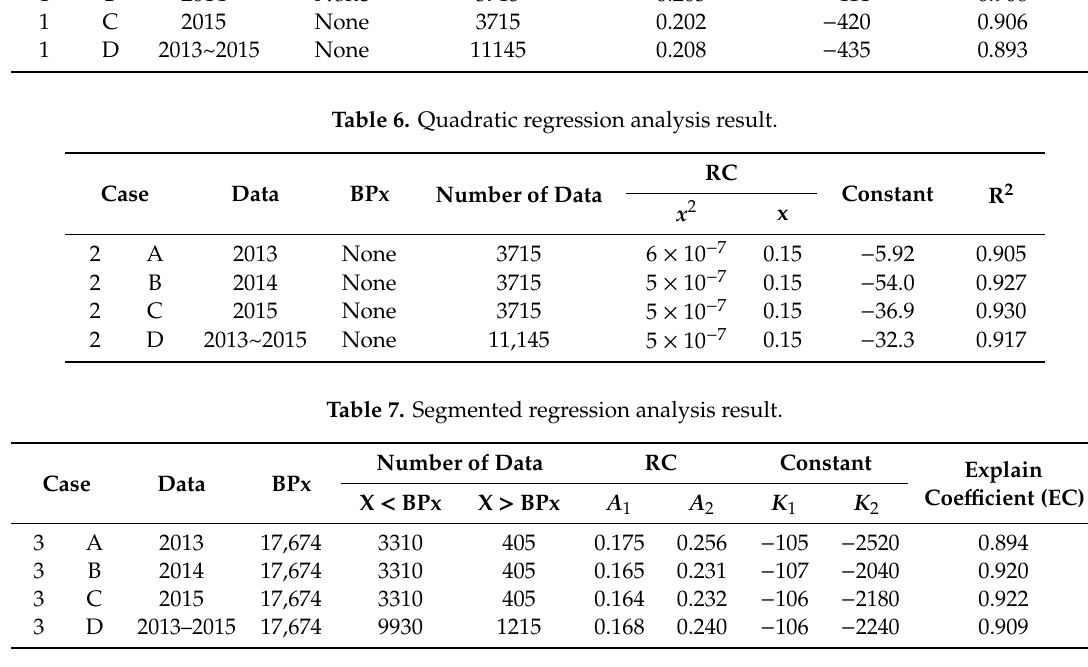
Table 5. Linear regression analysis result.